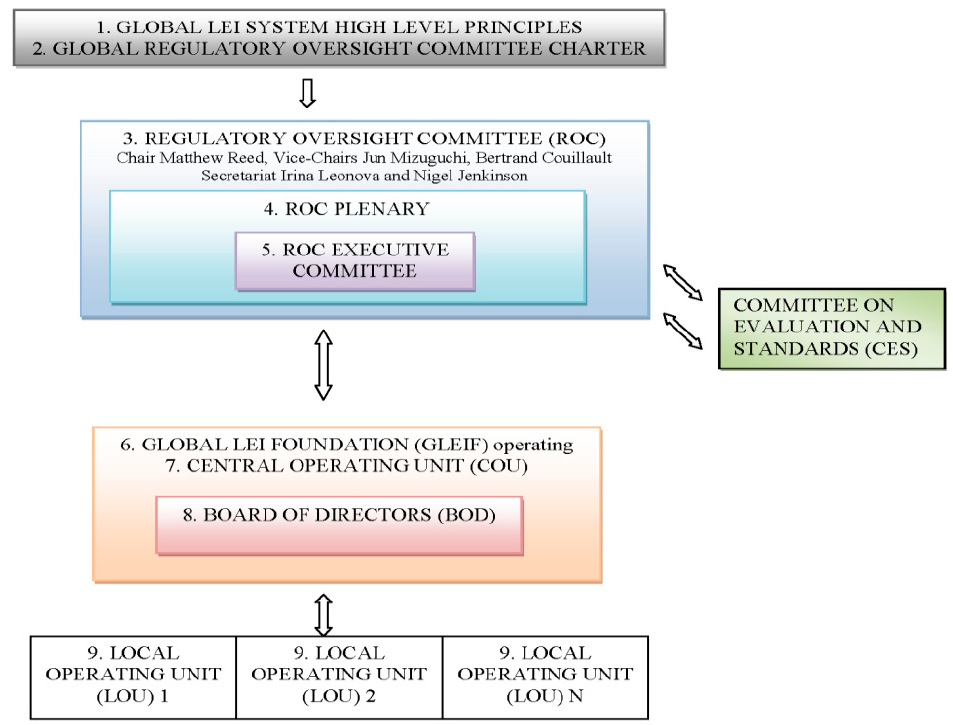
Figure 1. Federated Global LEI Structure. Source: LEI ROC ( http://www.leiroc.org/publications/leistructurediagram.pdf ).